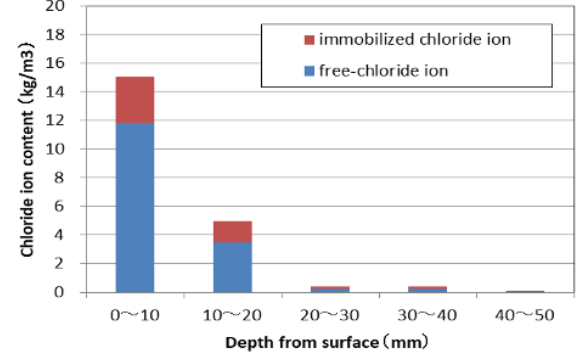
Figure 2. Chloride ion profile for N.